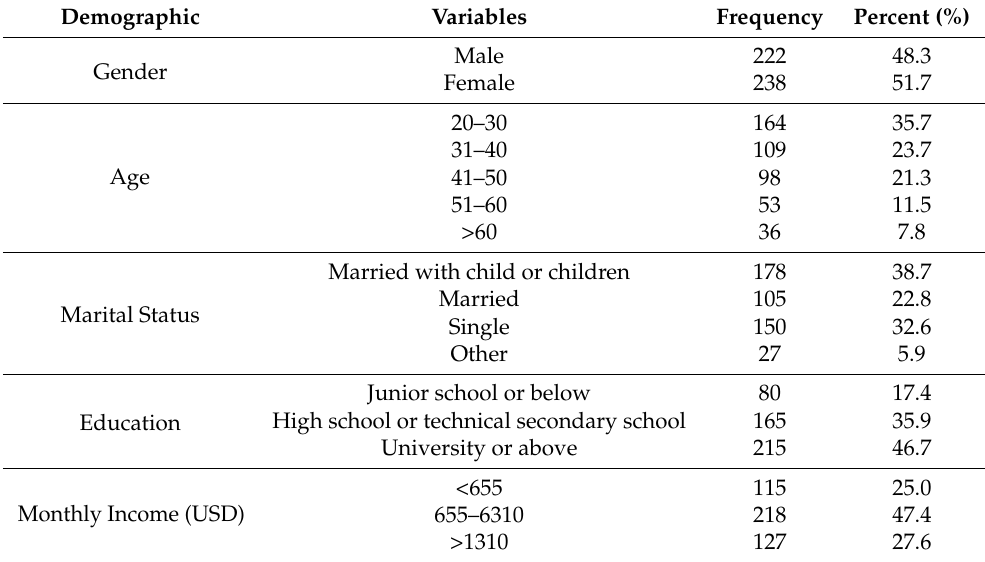
Table 2. Demographic characteristics of samples (n = 460) in comparison to Chinese average